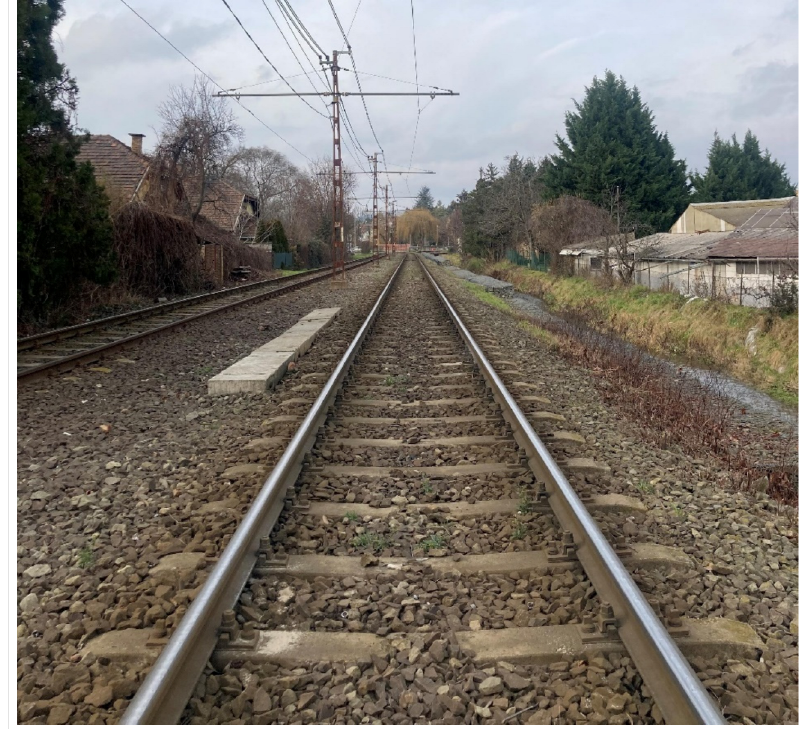
Figure 2. Photo of Section #2 (own photo).